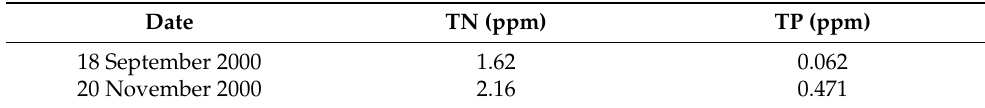
Table 2. TN and TP concentrations (ppm) in the Lake Agmon effluent measured on 18 September 2000 and 20 November 2000.